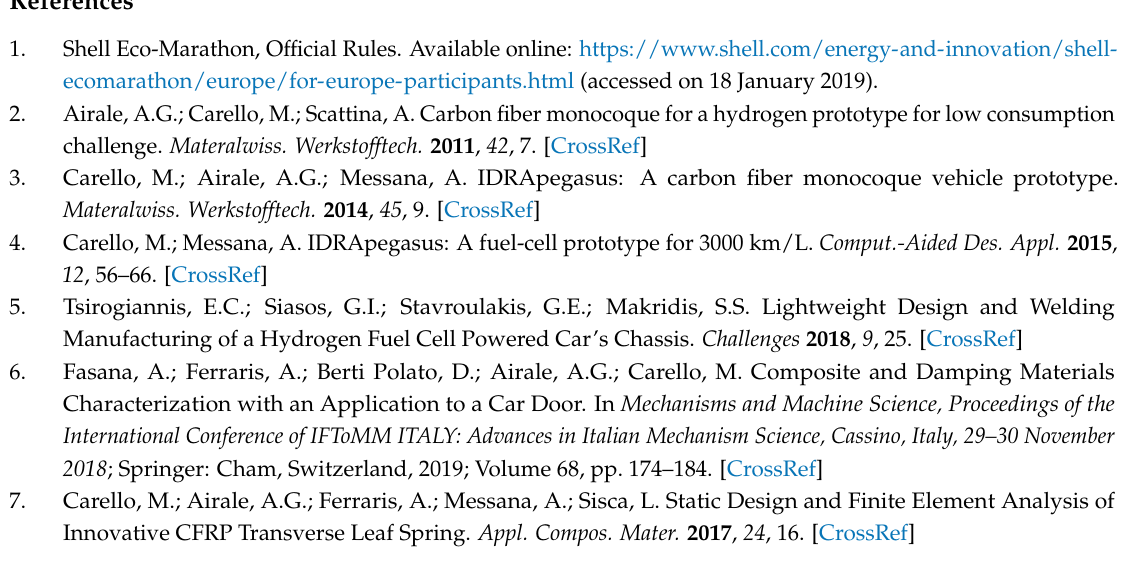
Figure 15 . Full vehicle body assembled . Figure 15. Full vehicle body